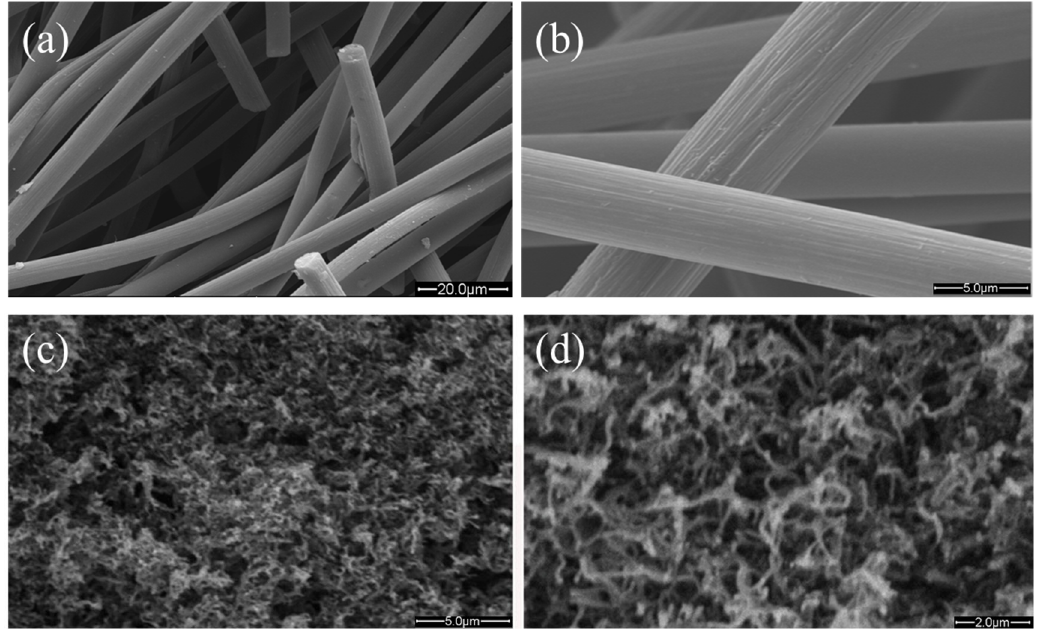
Figure 1. SEM images of the CF electrode (( a ) 1000× and ( b ) 5000×) and the modi fi ed electrode (( c ) 5000× and ( d ) 20,000×).